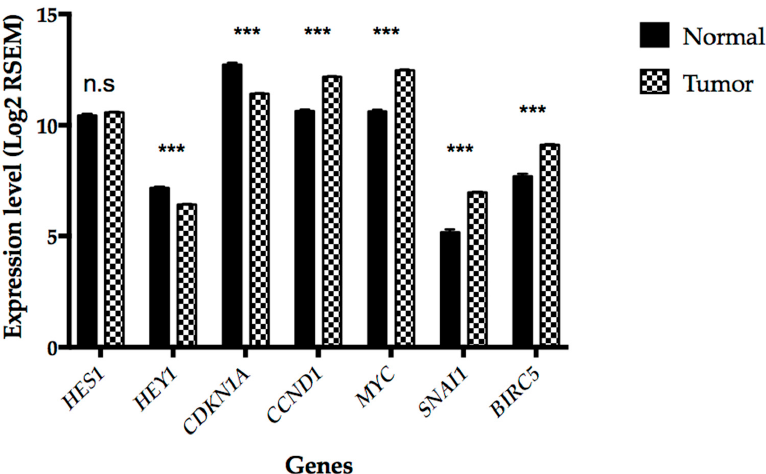
Figure 5. Expression of a set of NOTCH target genes. Data extracted from FireBrowse were obtained from 626 CRC and 51 normal adjacent tissues. The genes related to proliferation ( p21, c-Myc and Cyclin D1 ), EMT (Epithelial-to-Mesenchymal Transition) process ( Snail 1 ) and apoptosis ( Survivin ) are altered in their expressions in the sense of promoting tumor development. *** p < 0.001.